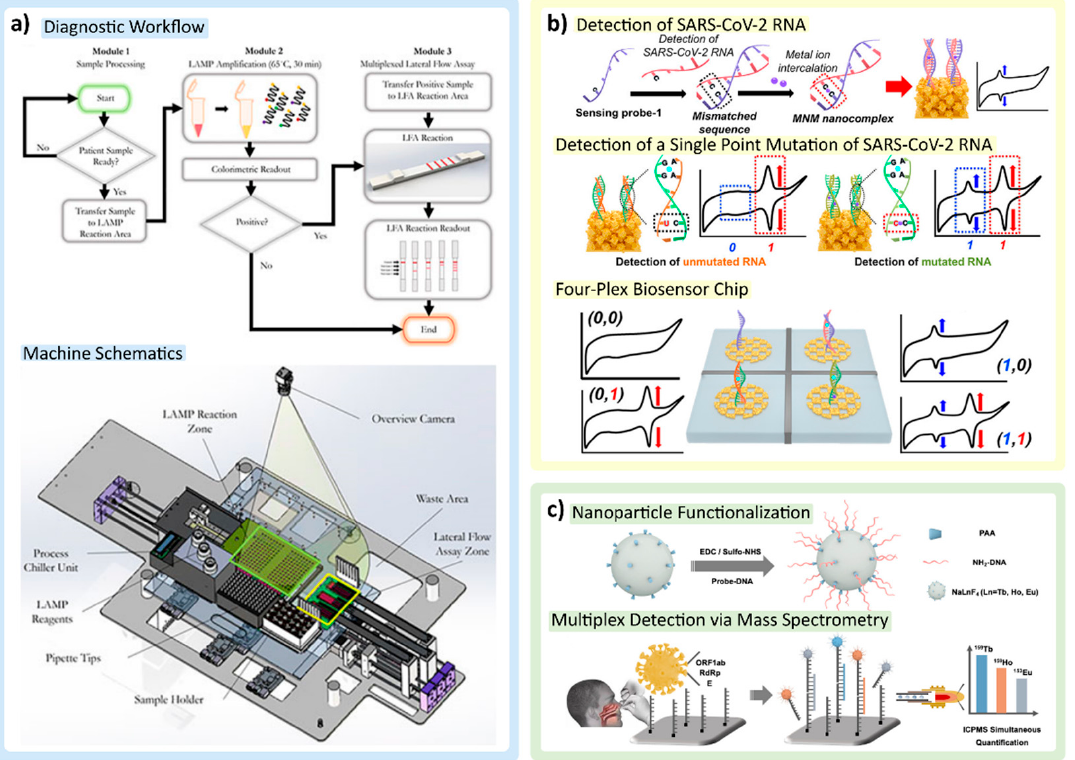
Figure 5. Colorimetric and electrochemical detection techniques: ( a ) Colorimetric detection methods using pH indicator in LAMP reagent mix and gold nanoparticle aggregation on the paper strips are combined into one workflow and implemented within a workstation machine for high-throughput detection. Adapted with permission from Ref. [105]. Copyright 2022, the Authors. ( b ) Electrochemical detection of redox signal from mismatched nucleic acid–metal ion nanocomplex. Adapted with permission from Ref. [88]. Copyright 2022, American Chemical Society. ( c ) Lanthanide nanoparticle (LnNP)-tagging strategy coupled with mass spectrometry for multiplex detection. Adapted with permission from Ref. [83]. Copyright 2021, American Chemical Society.